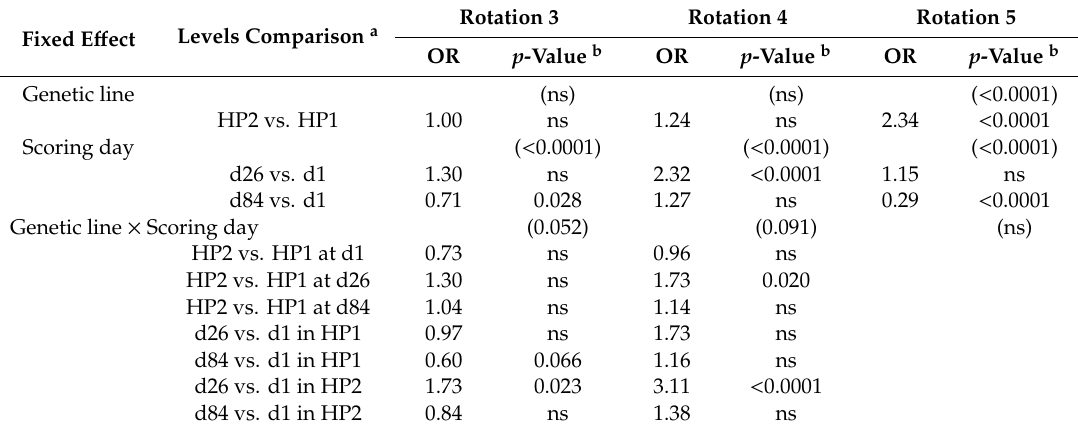
Table 4. Summary of the impact of genetic line (HP2 vs. HP1), scoring day (d1, d26, and d84) and their interaction on REAR body lesion scores within each rotation (3, 4, and 5).